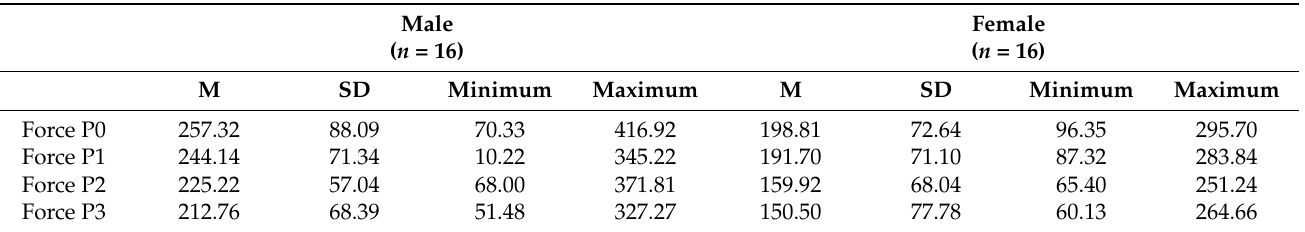
Table 5. Means (M), standard deviations (SD), minimums, and maximums for the independent samples by gender.